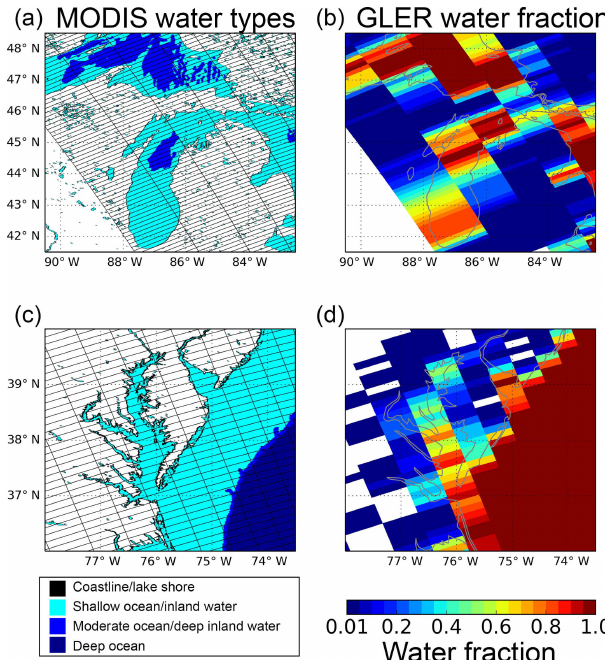
Figure 2. Pixel water fractions (color bar) estimated in GLER (b, d) with a MODIS 30 (cid:48)(cid:48) land–water map (a, c) with OMI pixel poly- gons on the top. The color legend denotes surface categories defined in the original MODIS data. Panels (a) and (b) : region of Lakes Su- perior and Michigan; panels (c) and (d) : Chesapeake